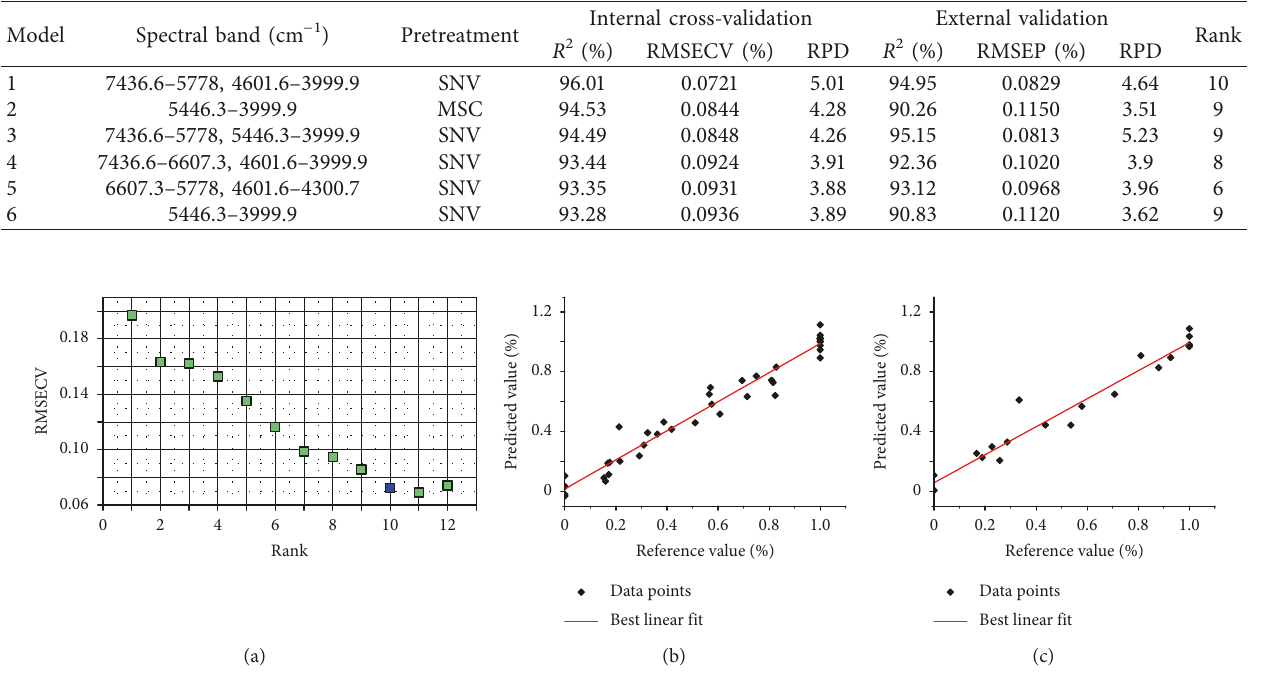
Table 4: NIR models for predicting characteristic T value of XRD